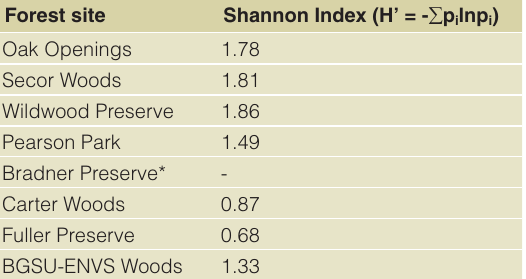
Table 9. Shannon Diversity Index Values for Forest Study